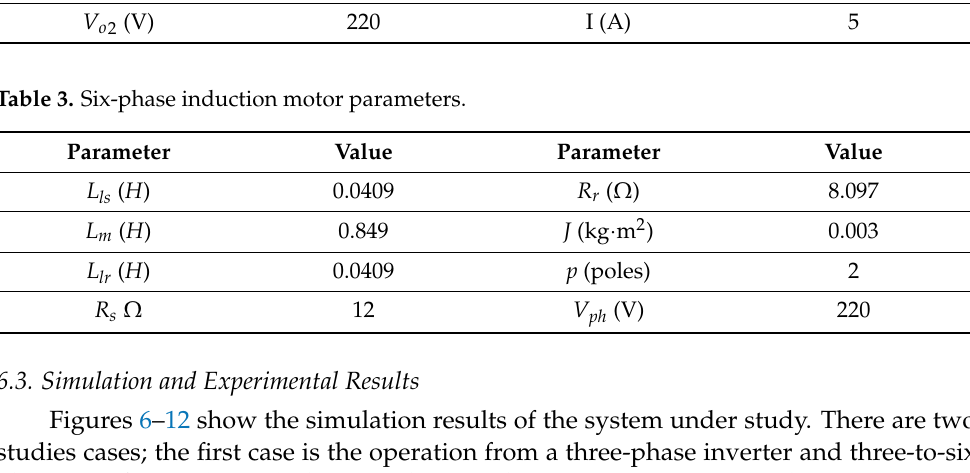
Figure 6. Speed–time characteristics: ( a ) with 3-phase inverter and transformer, ( b ) with 6-phase inverter.